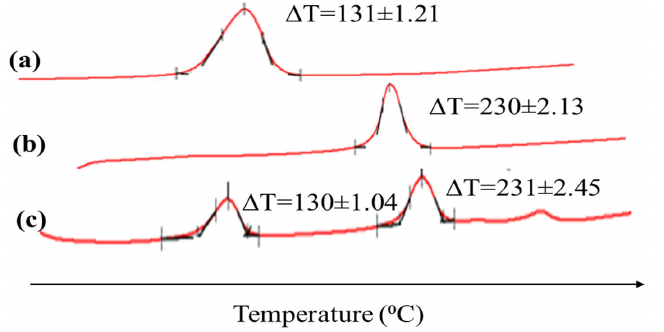
Figure 2. DSC thermograms of ( a ) pantoprazole, ( b ) clarithromycin, and ( c ) formulation F7.